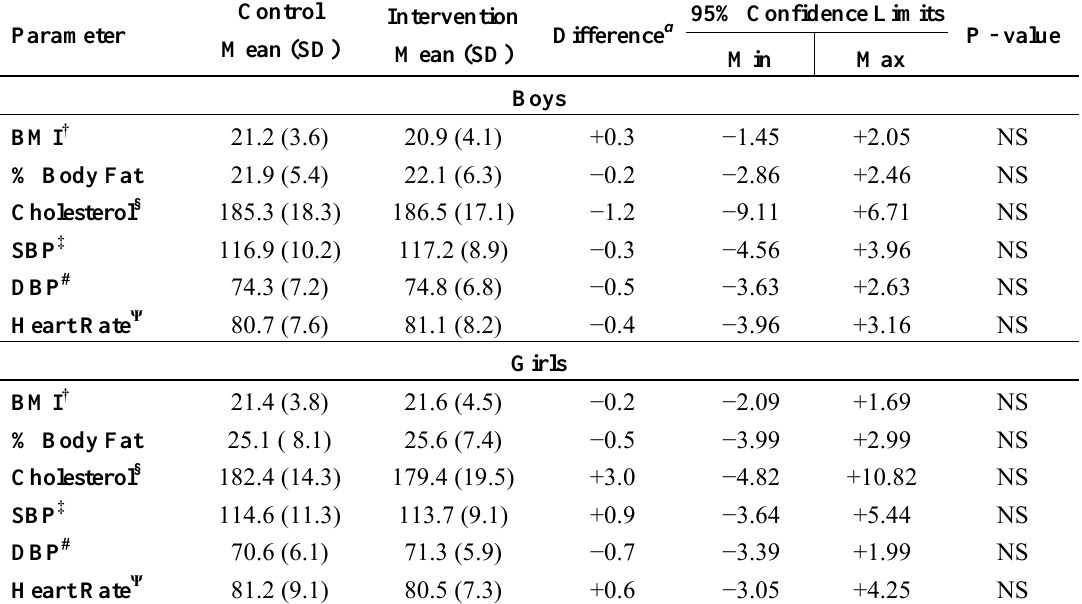
Table 1. Baseline anthropometric and physiological parameters of control and intervention pupils by gender.